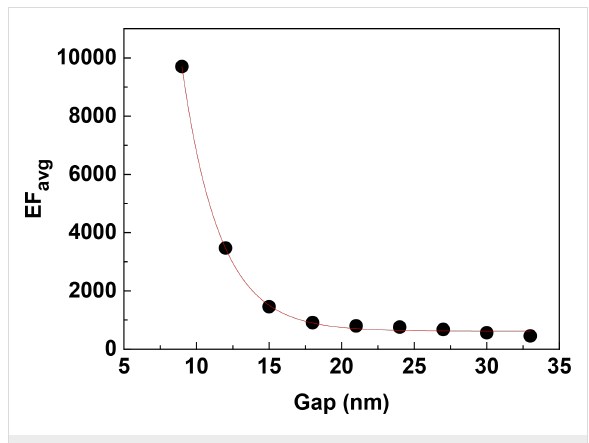
Figure 10: The dependence of EF avg on the gap size along the y -direction in S42 AgNR 2D hexagonal array with AR = 3.5. The solid curve is an exponential fitting result. The excitation wavelength is 632.8 nm and the polarization is parallel to the y